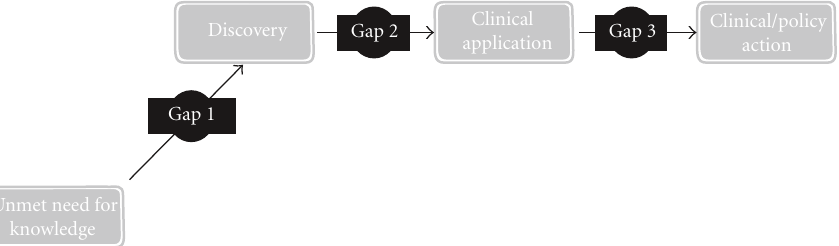
Figure 3: Three translation gaps in healthcare knowledge ([13], 2010).